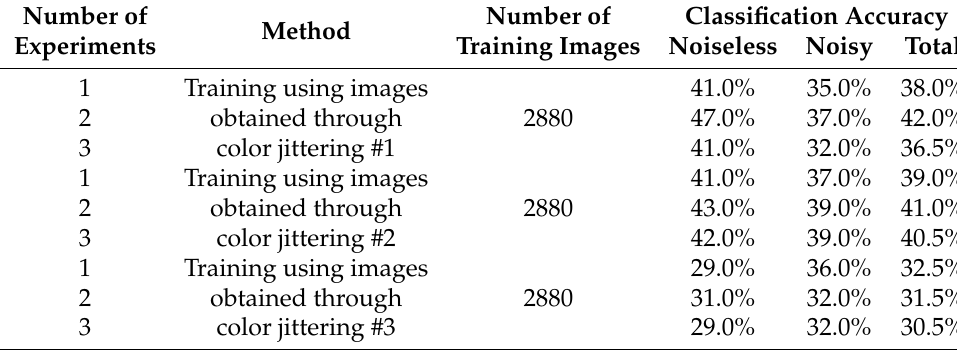
Table 2. Classification accuracy of the network trained using the conventional method.